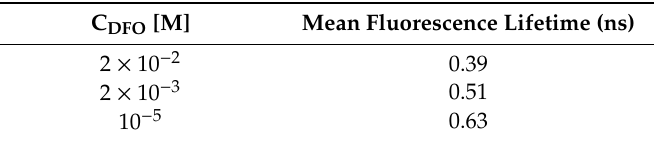
Table3. Themeanfluorescencelifetime(amplitudeweighted)ofDFOinTiO 2 thinfilms. λ obs. = 450 nm; λ ex. = 370